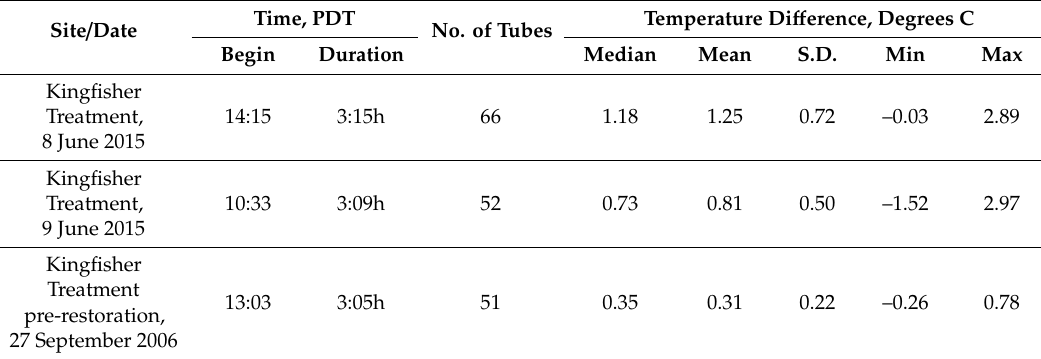
Table 3. Summary of intra-gravel streambed temperature